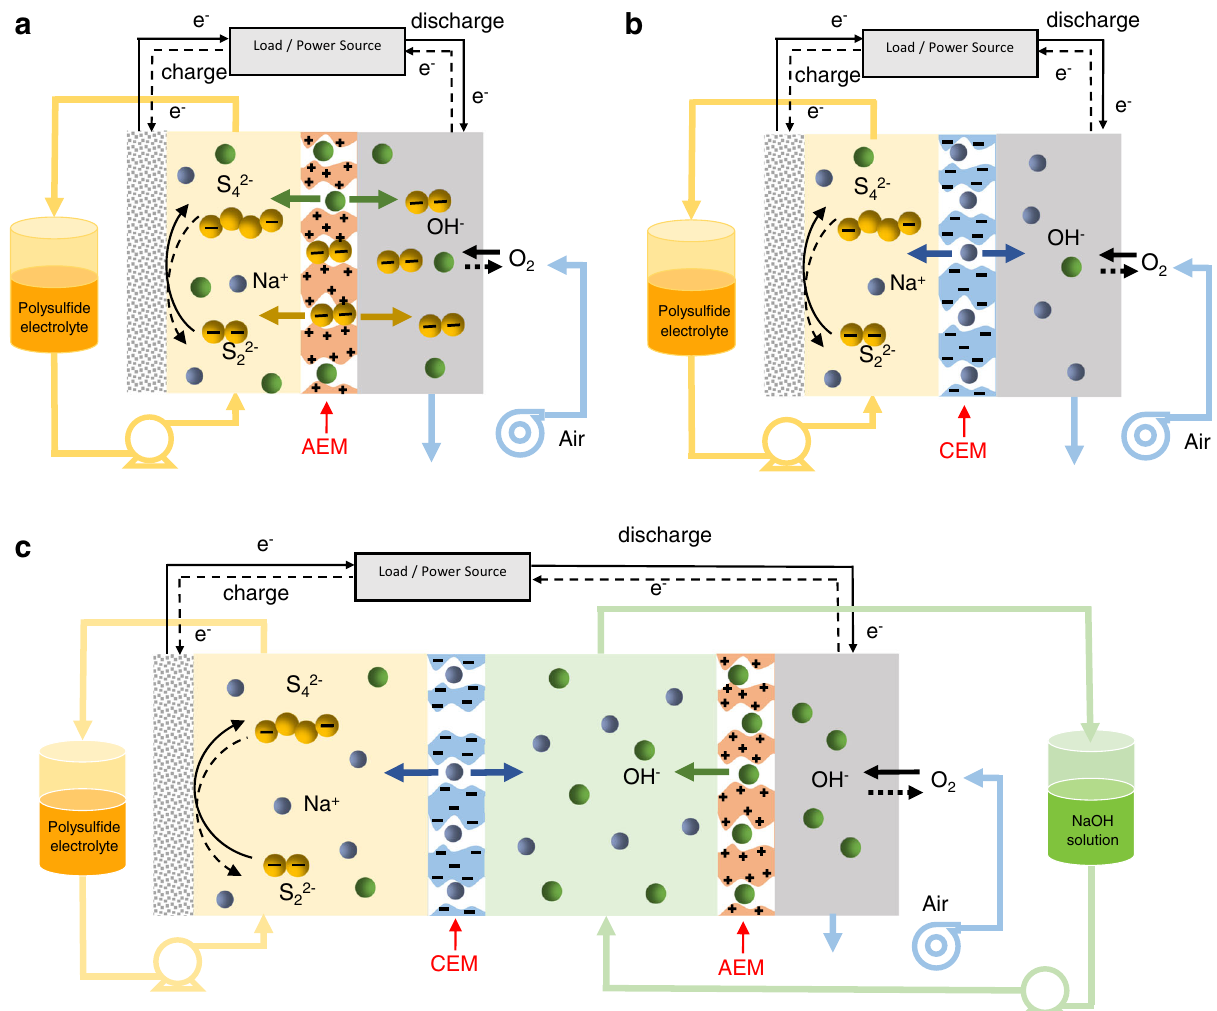
Fig. 1 Schematic diagrams of alkaline polysul fi de/air redox fl ow battery systems. a RFB based on single anion-exchange membrane. b RFB based on single cation-exchange membrane. c RFB based on double-membrane design combining anion-exchange membrane and cation-exchange